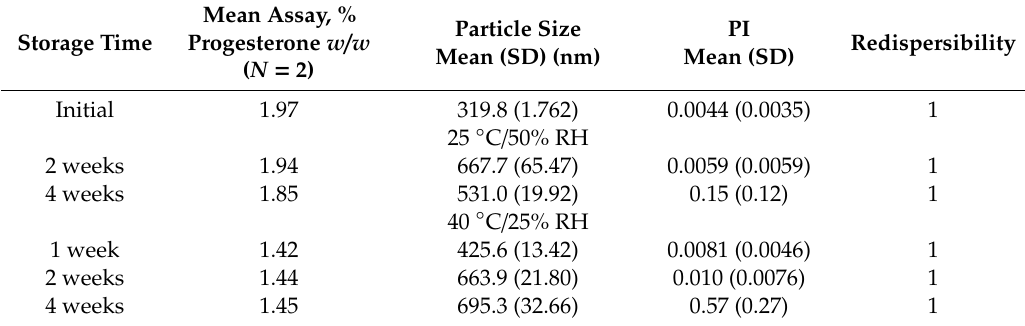
Table 9. Summary of short-term stability study of progesterone-loaded stearic acid SLNs. Redispersion qualitative scale: 1 − fully redispersed within 30 s of vortexing; 2—a few remaining undispersed